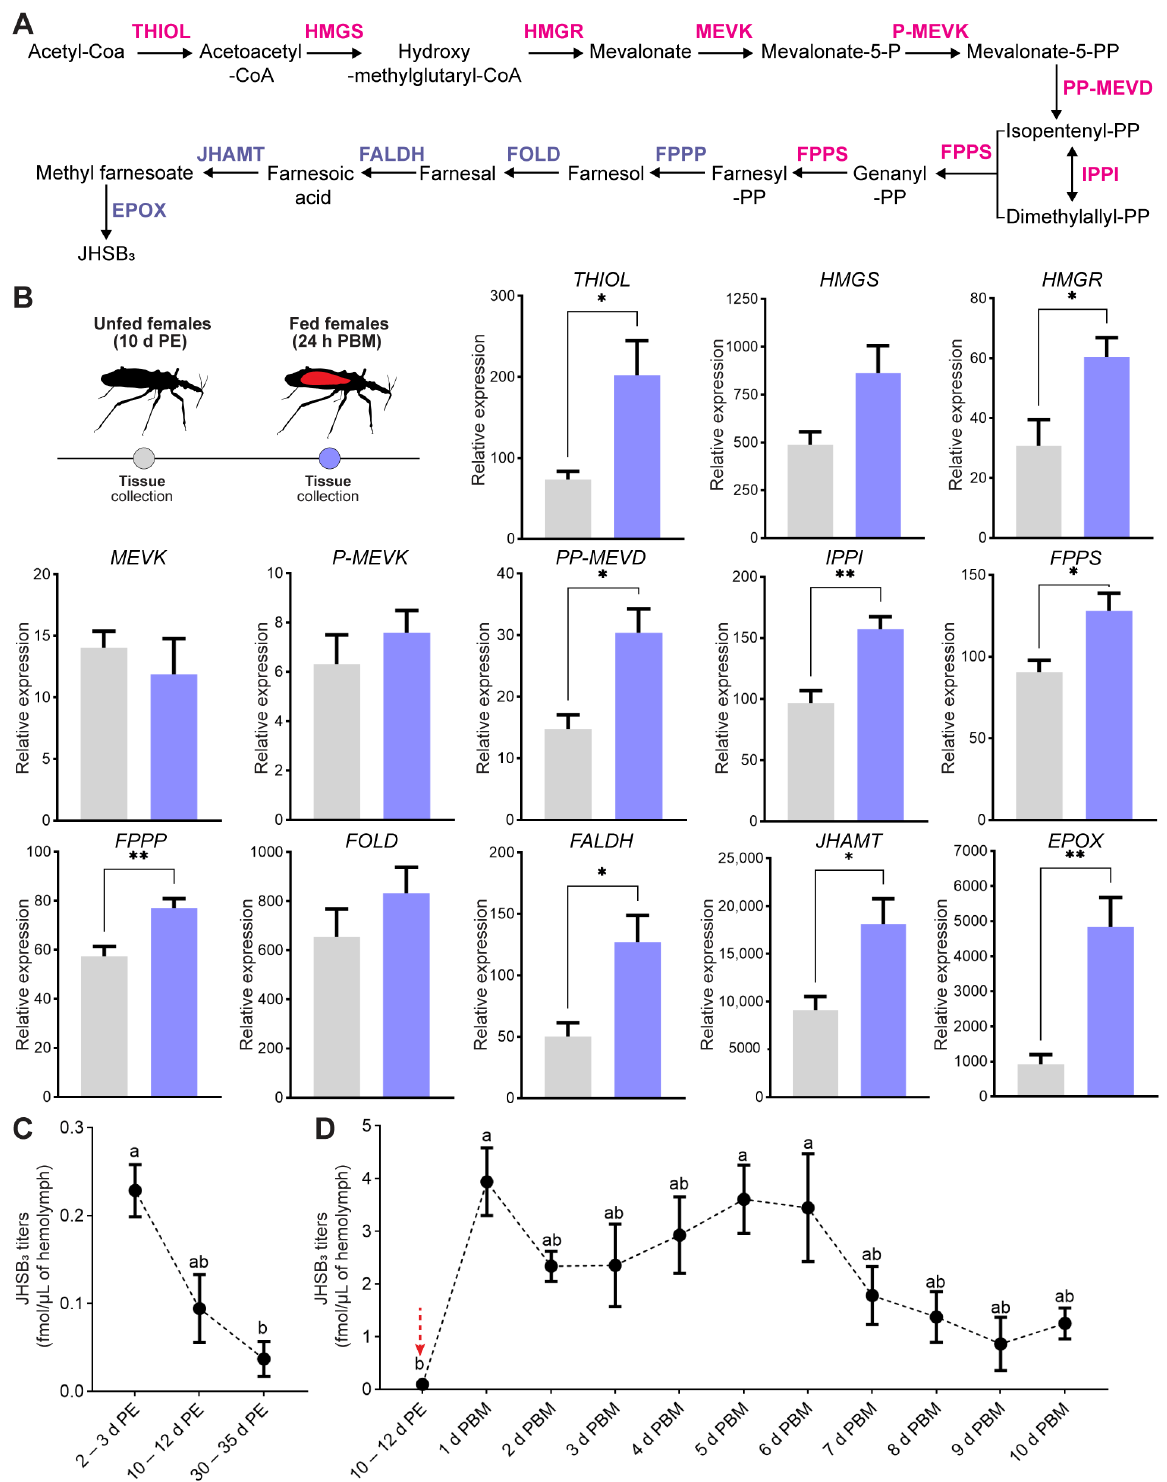
Figure 1. JHSB 3 production in R. prolixus after a blood meal. ( A ) Scheme of JHSB 3 biosynthesis. Precursors are connected by arrows; enzymes of the early step are in pink and enzymes of the late step